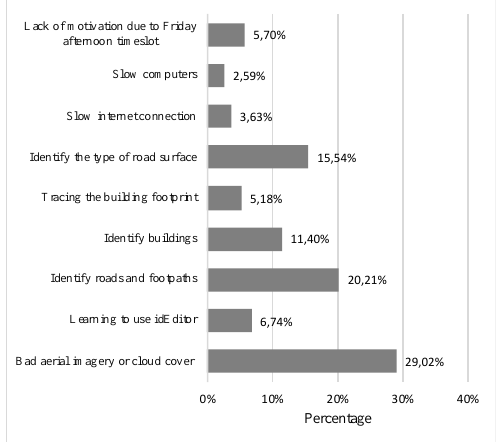
Figure 5. Difficulties and challenges encountered by